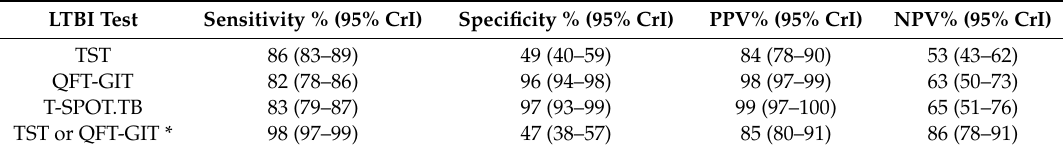
Table 5. Performance of diagnostic tests for latent tuberculosis infection in healthcare workers using a latent class model using more informative prior information on specificities and sensitivities (N = 472). LTBI